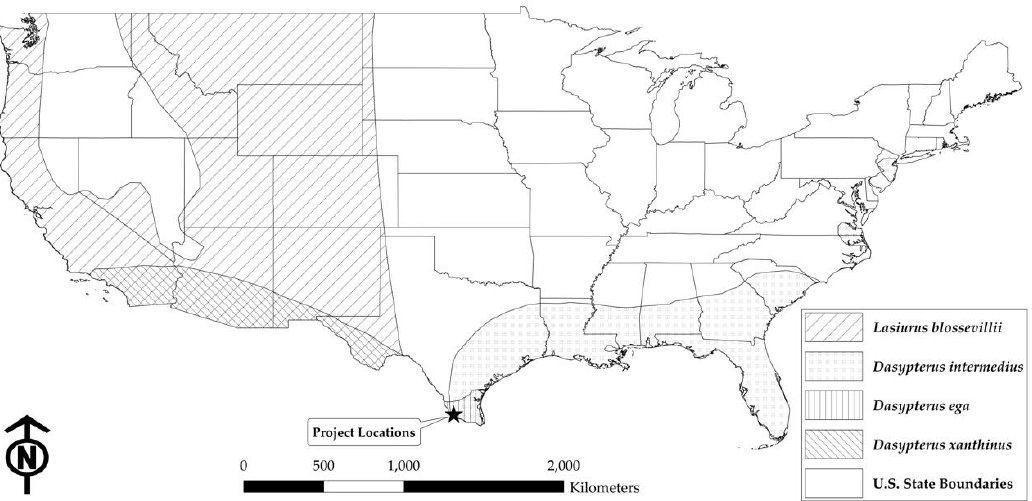
Figure 5. IUCN (International Union for the Conservation of Nature) Red List range maps for L. blossevillii [38], D. intermedius [39], D. ega [40], and D. xanthinus [41] within the continental USA. The star indicates the location of the wind energy facilities included in this study.